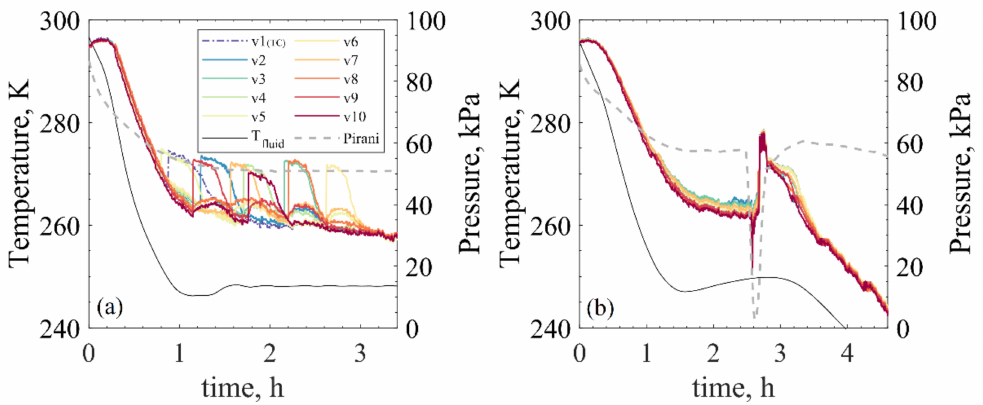
Figure 3. T bottom freezing profiles of the spontaneous nucleation ( a ) and VISF at 263 K ( b ) in the case of OFF shelf vials and 5%